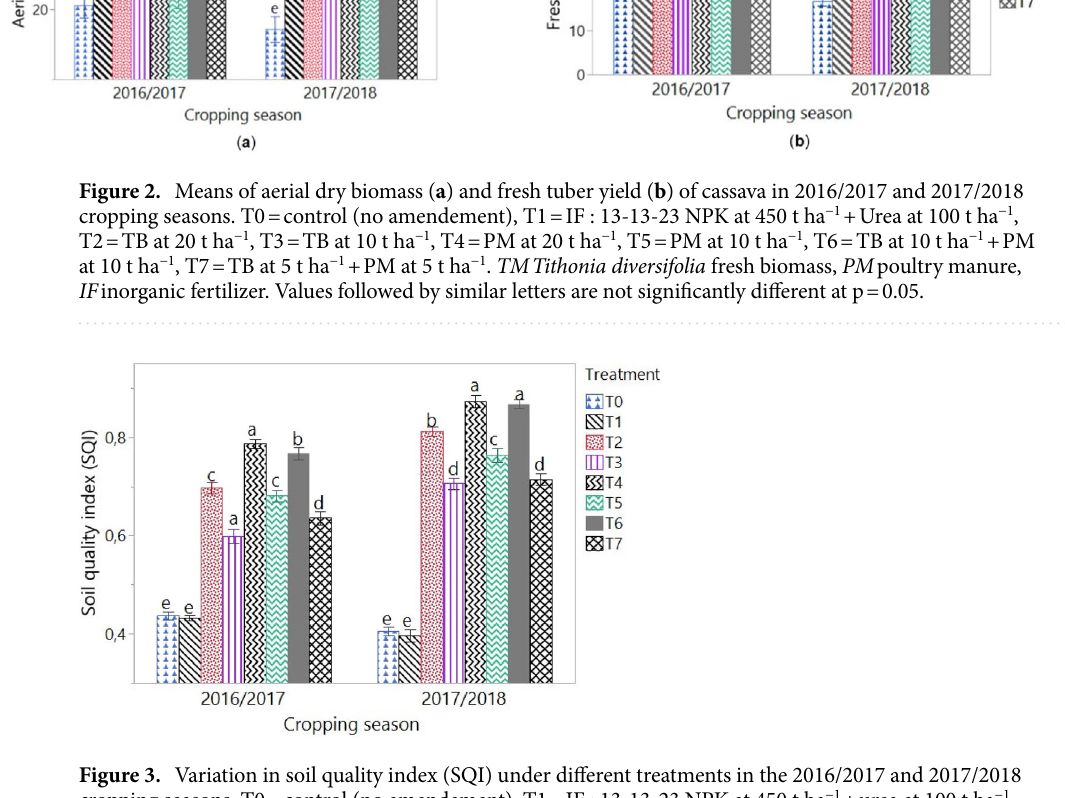
in all plot treated with organic manures (T2 to T7), while it remained stable in the control (T0) and inorganic fertilizer (T1) treatments. In 2016/2017 cropping season, the SQI values varied from 0.43 to 0.79 with an average